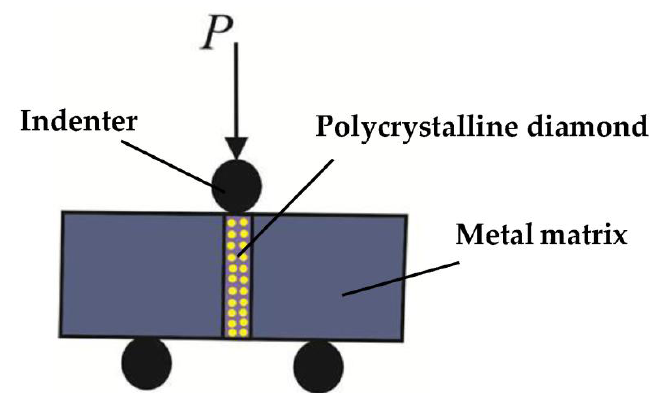
Figure 13. Scheme of felt-bending test method.